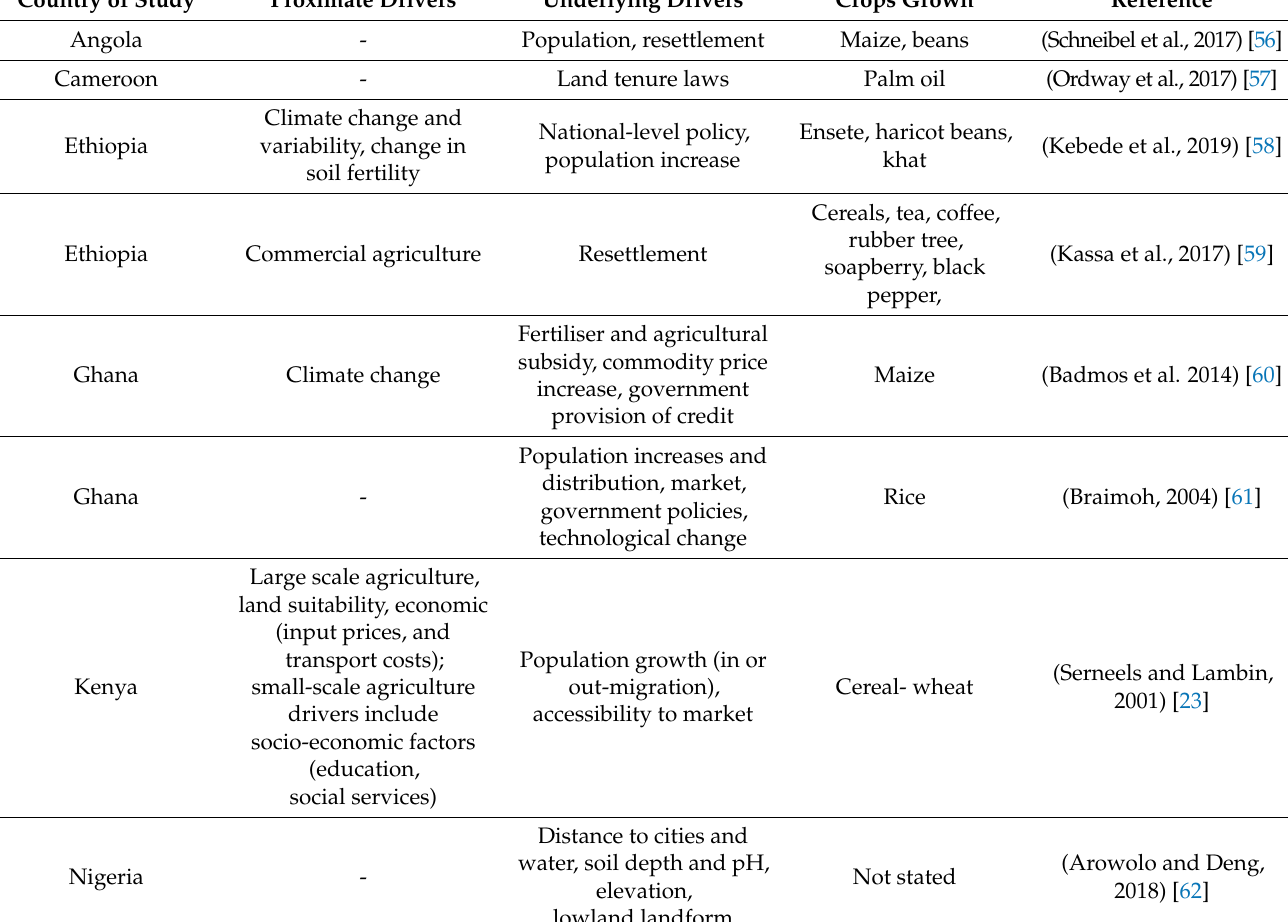
Table 2. Overview of agricultural expansion, crops grown, methods and country of study identified in literature. Country of Study Proximate Drivers Underlying Drivers Crops Grown Reference Angola - Population,